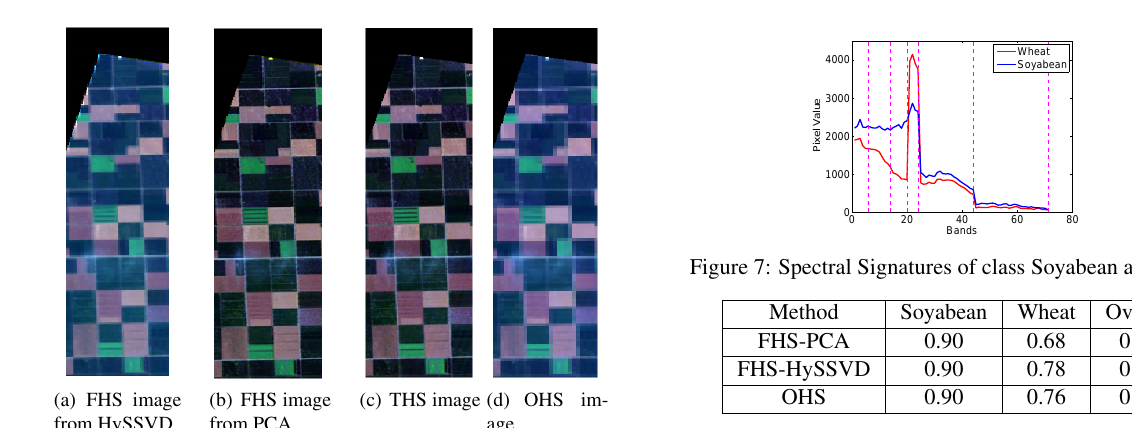
Table 4: Class wise Rank Correlation values for different meth- ods on mixed